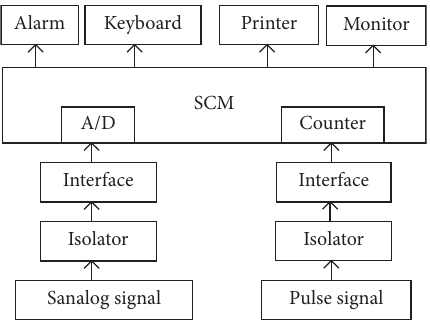
Figure 3: Host computer schematic diagram of continuous de- tection by the steady-flow pumping